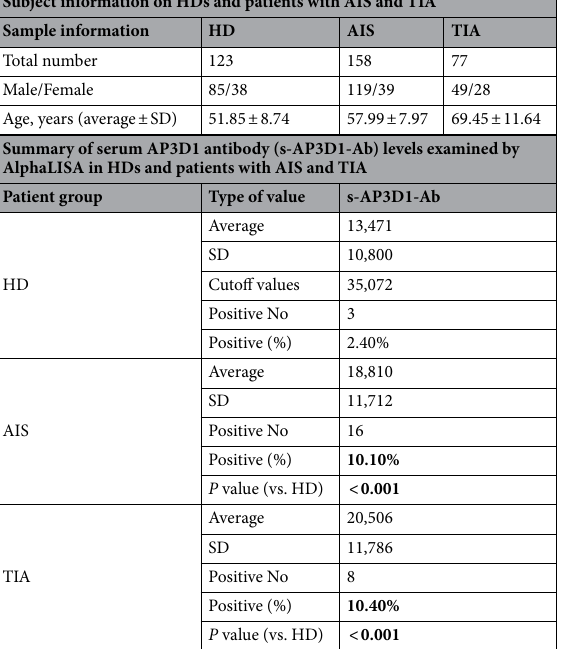
Table 1. Comparing the serum antibody levels against AP3D1 between healthy donors (HDs) and patients with AIS and TIA. The upper panel indicates the number of total samples, samples from male and female participants, and ages [average ± standard deviation (SD)]. The lower panel summarizes the serum AP3D1 antibodies (s-AP3D1-Abs) examined using amplified luminescence proximity homogeneous assay-linked immunosorbent assay (AlphaLISA) using purified AP3D1 protein as an antigen. Cutoff values were determined as the average HDs values plus two SDs, and positive samples for which the antibody levels exceeded the cutoff value were scored. P -values were calculated using the Kruskal–Wallis test (Mann–Whitney U test with Bonferroni’s correction applied). P -values of < 0.05 and positive rates of > 10% are marked in bold font. These data are plotted and shown in Fig. 1a,b. AP3D1 adaptor-related protein complex 3 subunit delta 1, s-AP3D1-Abs the serum anti-AP3D1 antibodies, AIS acute ischemic stroke, TIA transient ischemic